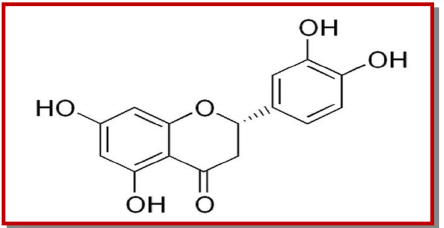
Figure 1: Chemical structure of eriodictyol